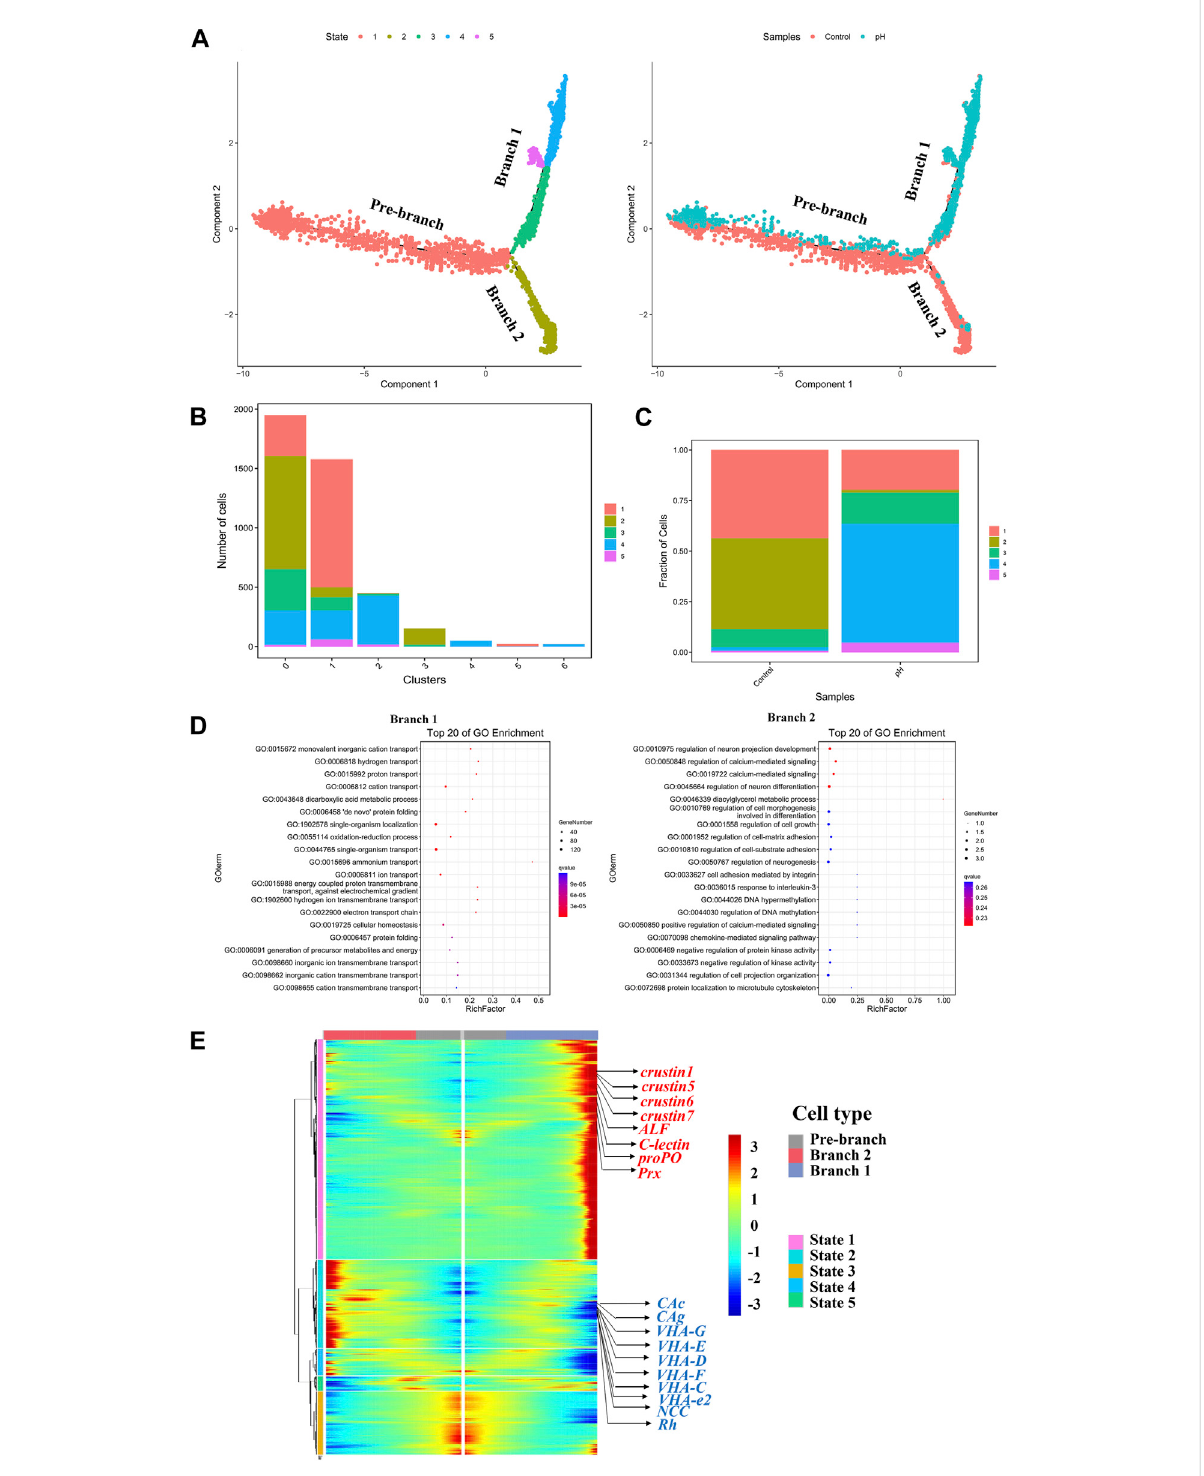
FIGURE 5 Reconstruction of the pillar cell subpopulation differentiation trajectory in a pseudotime manner. (A) Monocle 2 was used to track pillar cells in pseudotime using the scRNA-seq datasets. (B) The 7 subclusters of pillar cells distributed over 5 states of pseudotime differentiation trajectories. (C) Fraction of cells in the control and pH group distributed 5 states of pseudotime differentiation trajectories. (D) The GO enrichment of Branch 1 and Branch 2. (E) The pseudotime branch heatmap of pillar